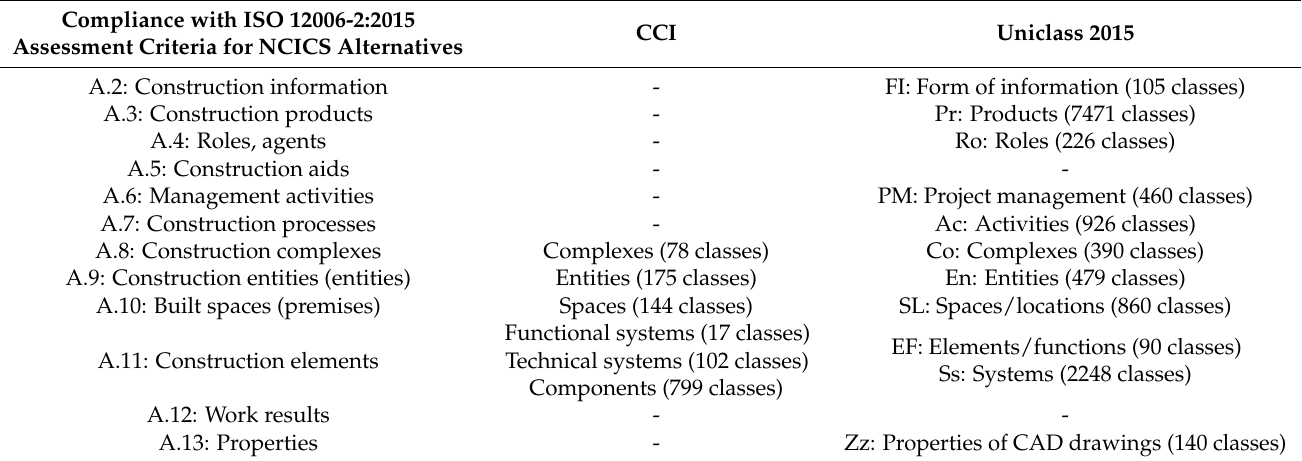
Table 5. Compliance with ISO 12006-2:2015 assessment criteria for NCICS